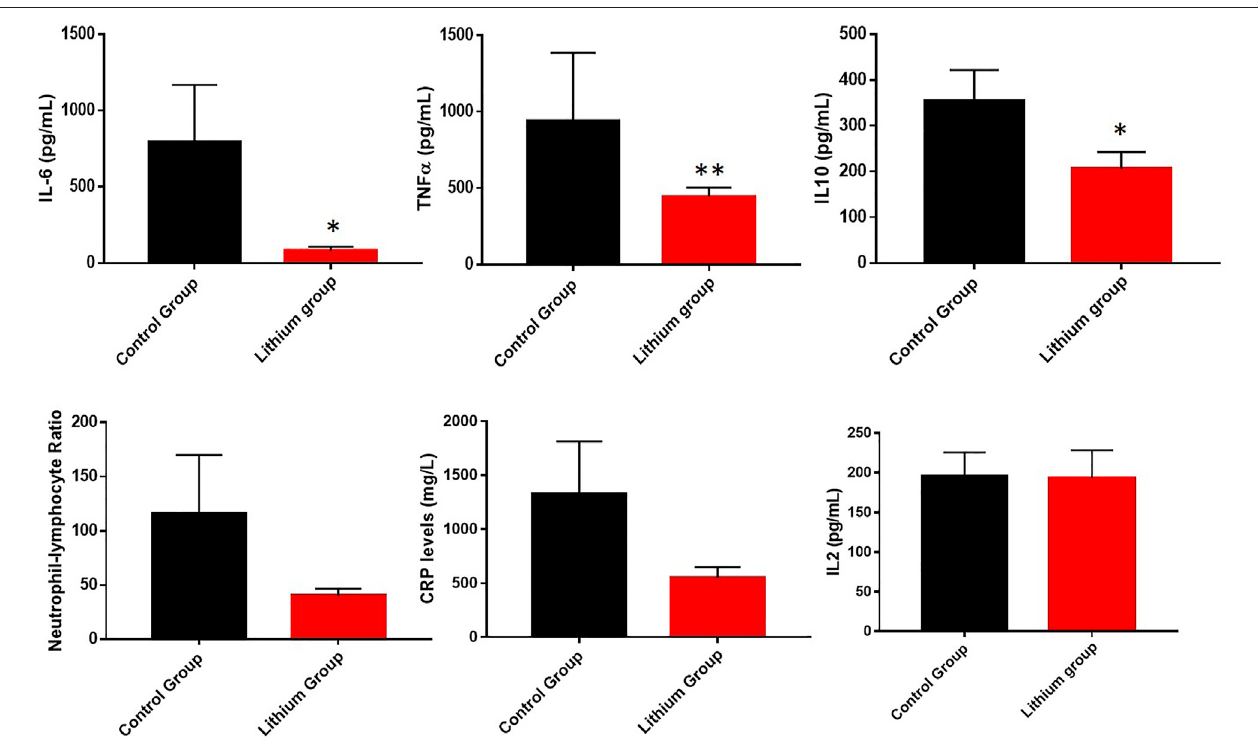
FIGURE3| Representationofdifferentparametersinvolvedingeneralin fl ammation.Weshowedareductionofgeneralin fl ammationinthegroupofpatientstreated with lithium. The graphs represent the area under the curve of cytokine levels measured during the study. * p < 0.05 and ** p < 0.01. Upper graphs represented the changes of IL-6, TNF α and IL-10 between control group and lithium group. The graphs below showed the area under the curve of the C-reactive protein graphs and neutrophil - lymphocyte ratio of all patients, control group and lithium group. We observed a tendency in the reduction of CRP levels and alower index of general in fl ammation without signi fi cance differences ( p = 0.12 for NLR and p = 0.15 for CRP levels).